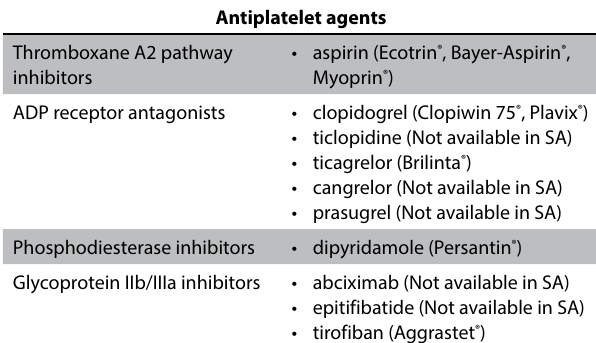
Table 1. Summary of available antiplatelet drugs and mechanism of